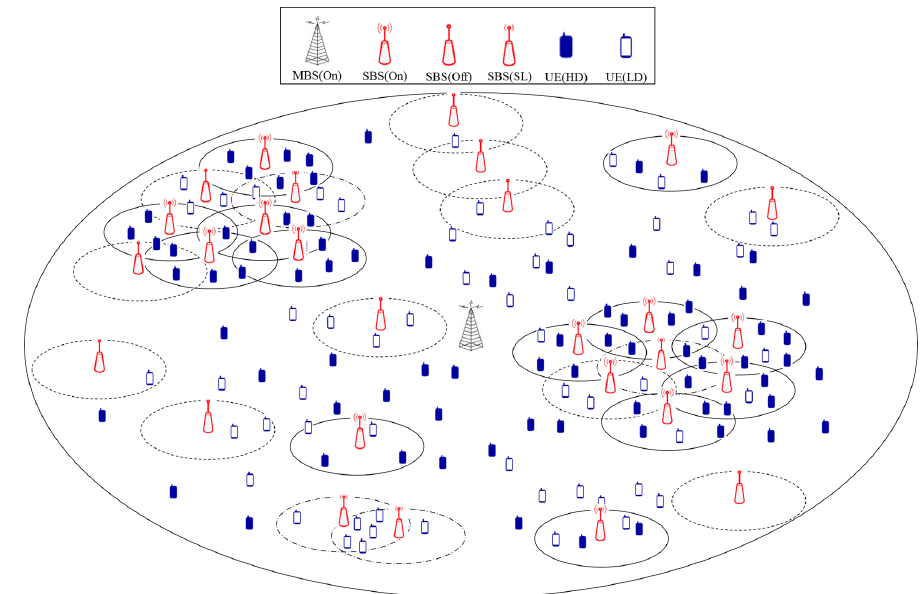
Figure 8. Network configuration. Figure 8. Network